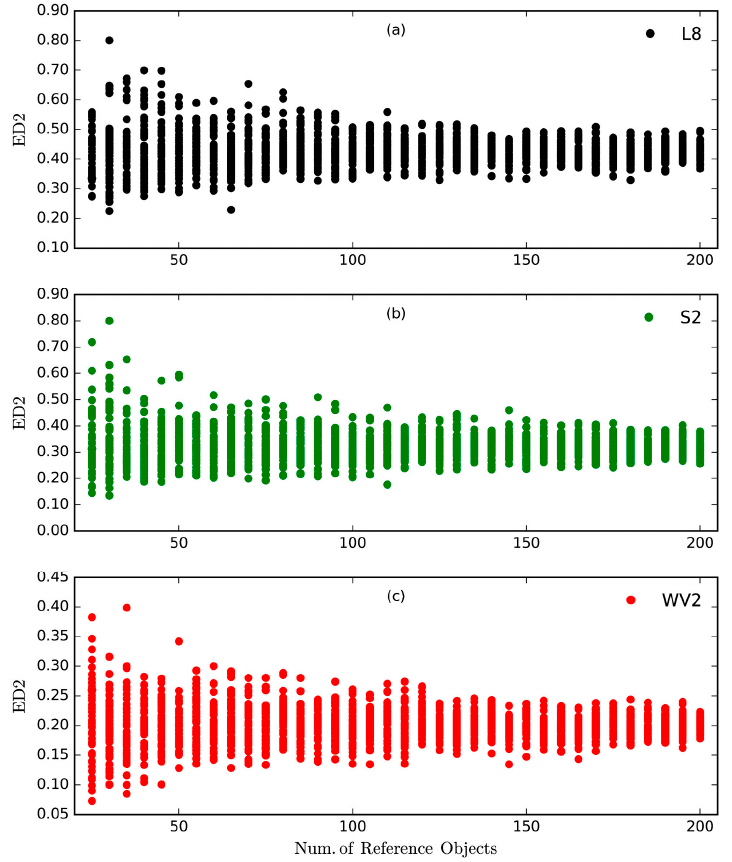
Figure 4. Scatter plots ED2—number of reference objects (ROs): ( a ) Landsat 8; ( b ) Sentinel-2; ( c ) WorldView-2.